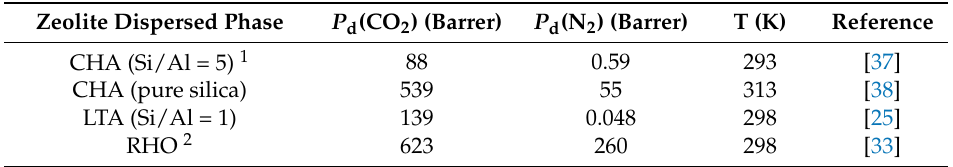
Table 3. Permeability data of the pure zeolite dispersed phase, P d , used for the model predictions. Zeolite Dispersed Phase